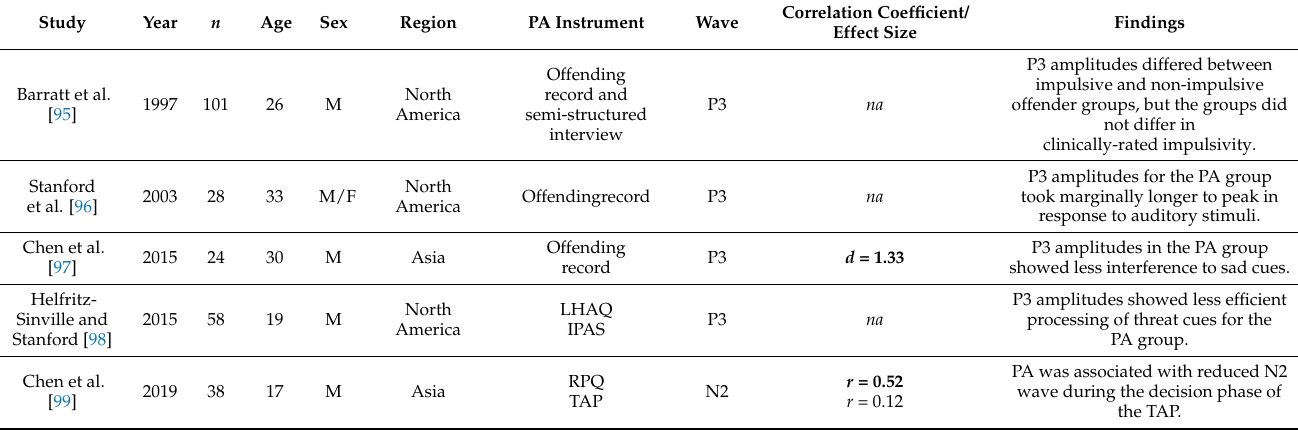
Table 5. Findings relating to proactive aggression event-related potentials, according to year of publication.